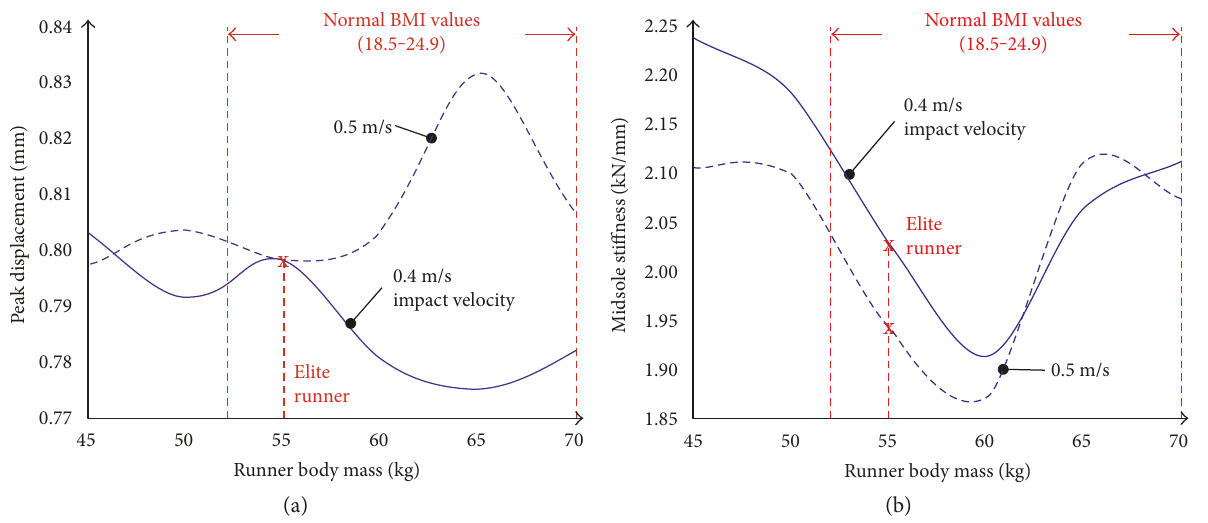
Figure 5: Runner body mass-dependent (a) displacement at peak force and (b) average midsole sti ff